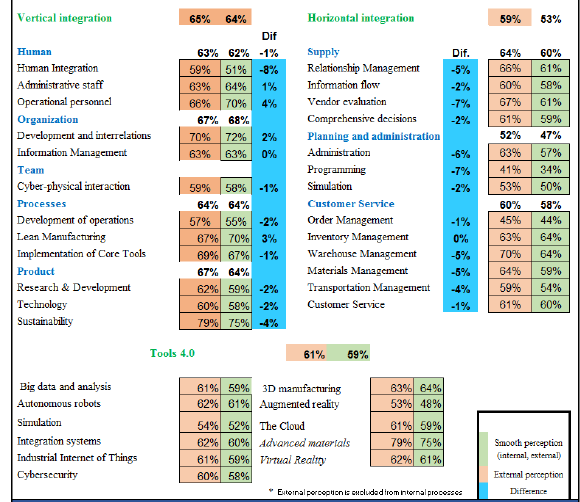
Fig. 2. Application result absorption tool in industry technologies 4.0. Source: Own elaboration.